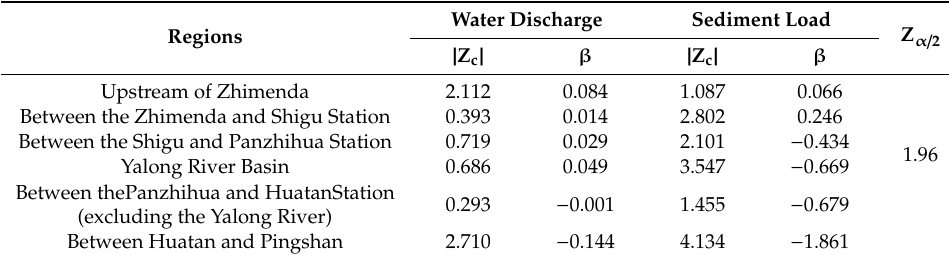
Table 3. Spatial and temporal trend change of the water discharge and sediment load in di ff erent regions of the Jinsha River Basin using the Mann–Kendall test (1966–2015).